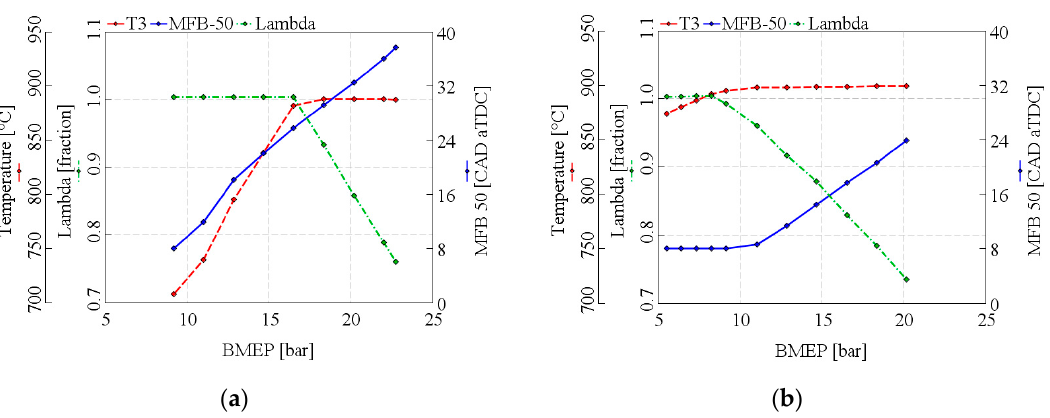
Figure 3. Load sweeps for the reference engine. Turbine inlet temperature in red dashed line, MFB50 in blue solid line and Lambda in green dash-dotted line as a function of Brake Mean Effective Pressure (BMEP): ( a ) engine speed 2000 RPM; ( b ) engine speed 5500 RPM.